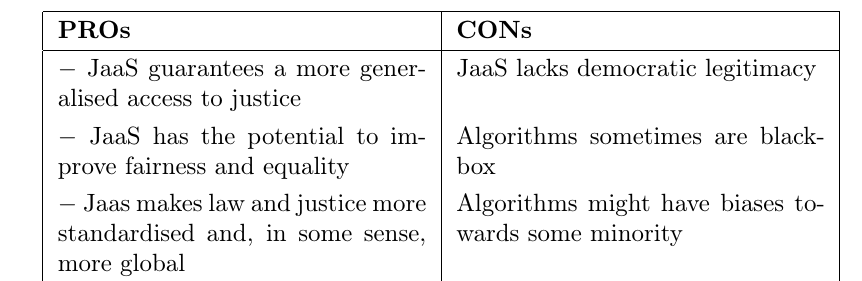
Table 2. Key points from this section: JaaS’ Pros and